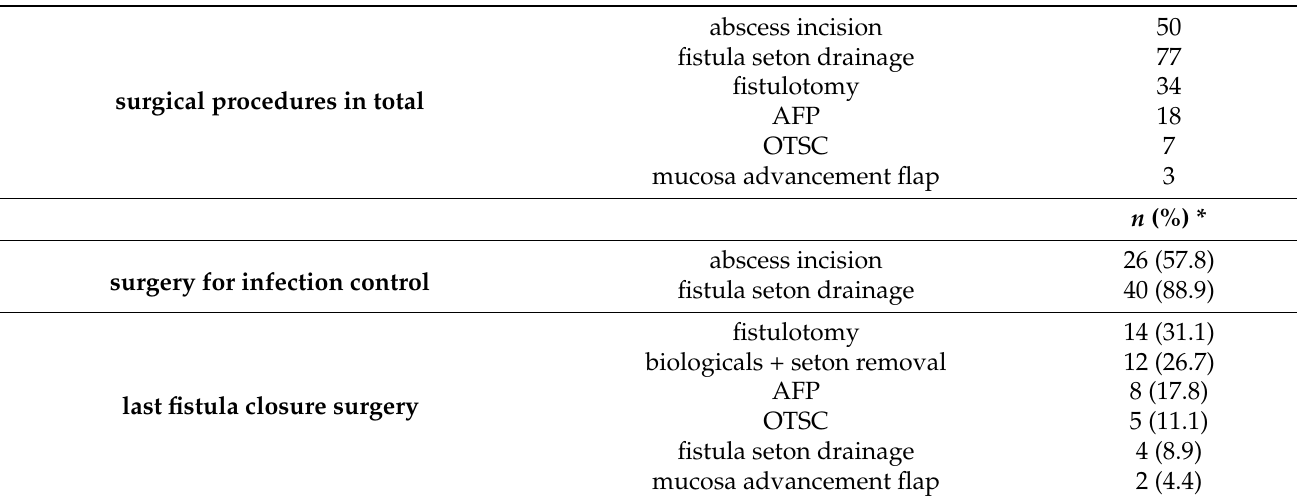
Table 4. Surgical treatment